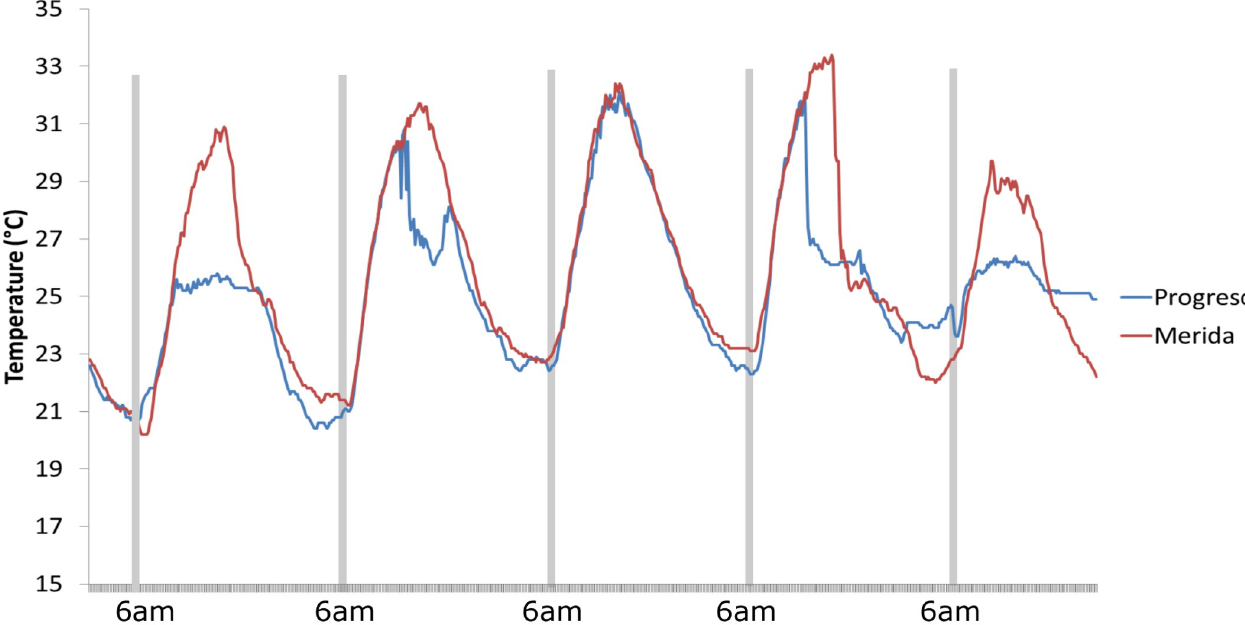
Fig 5. Time series of Merida and Progreso, from January 1 to January 5, 2015. The graph shows that Merida has a time series with fewer fluctuations than that of Progreso, and in this case, the fluctuation or “smoothness” of the data generates greater visibility between the datapoints. The more rugged the time series is, the lower the visibility and connectivity, and therefore, the mean degree will be